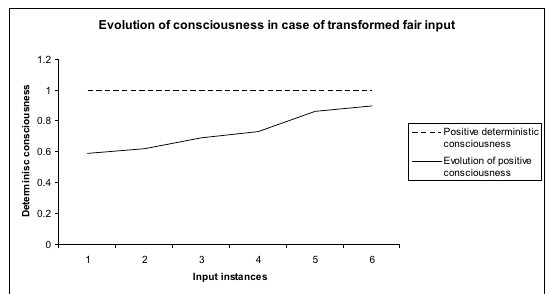
Fig. 24. Evolution of consciousness in system with transformed excitation (fair C2).